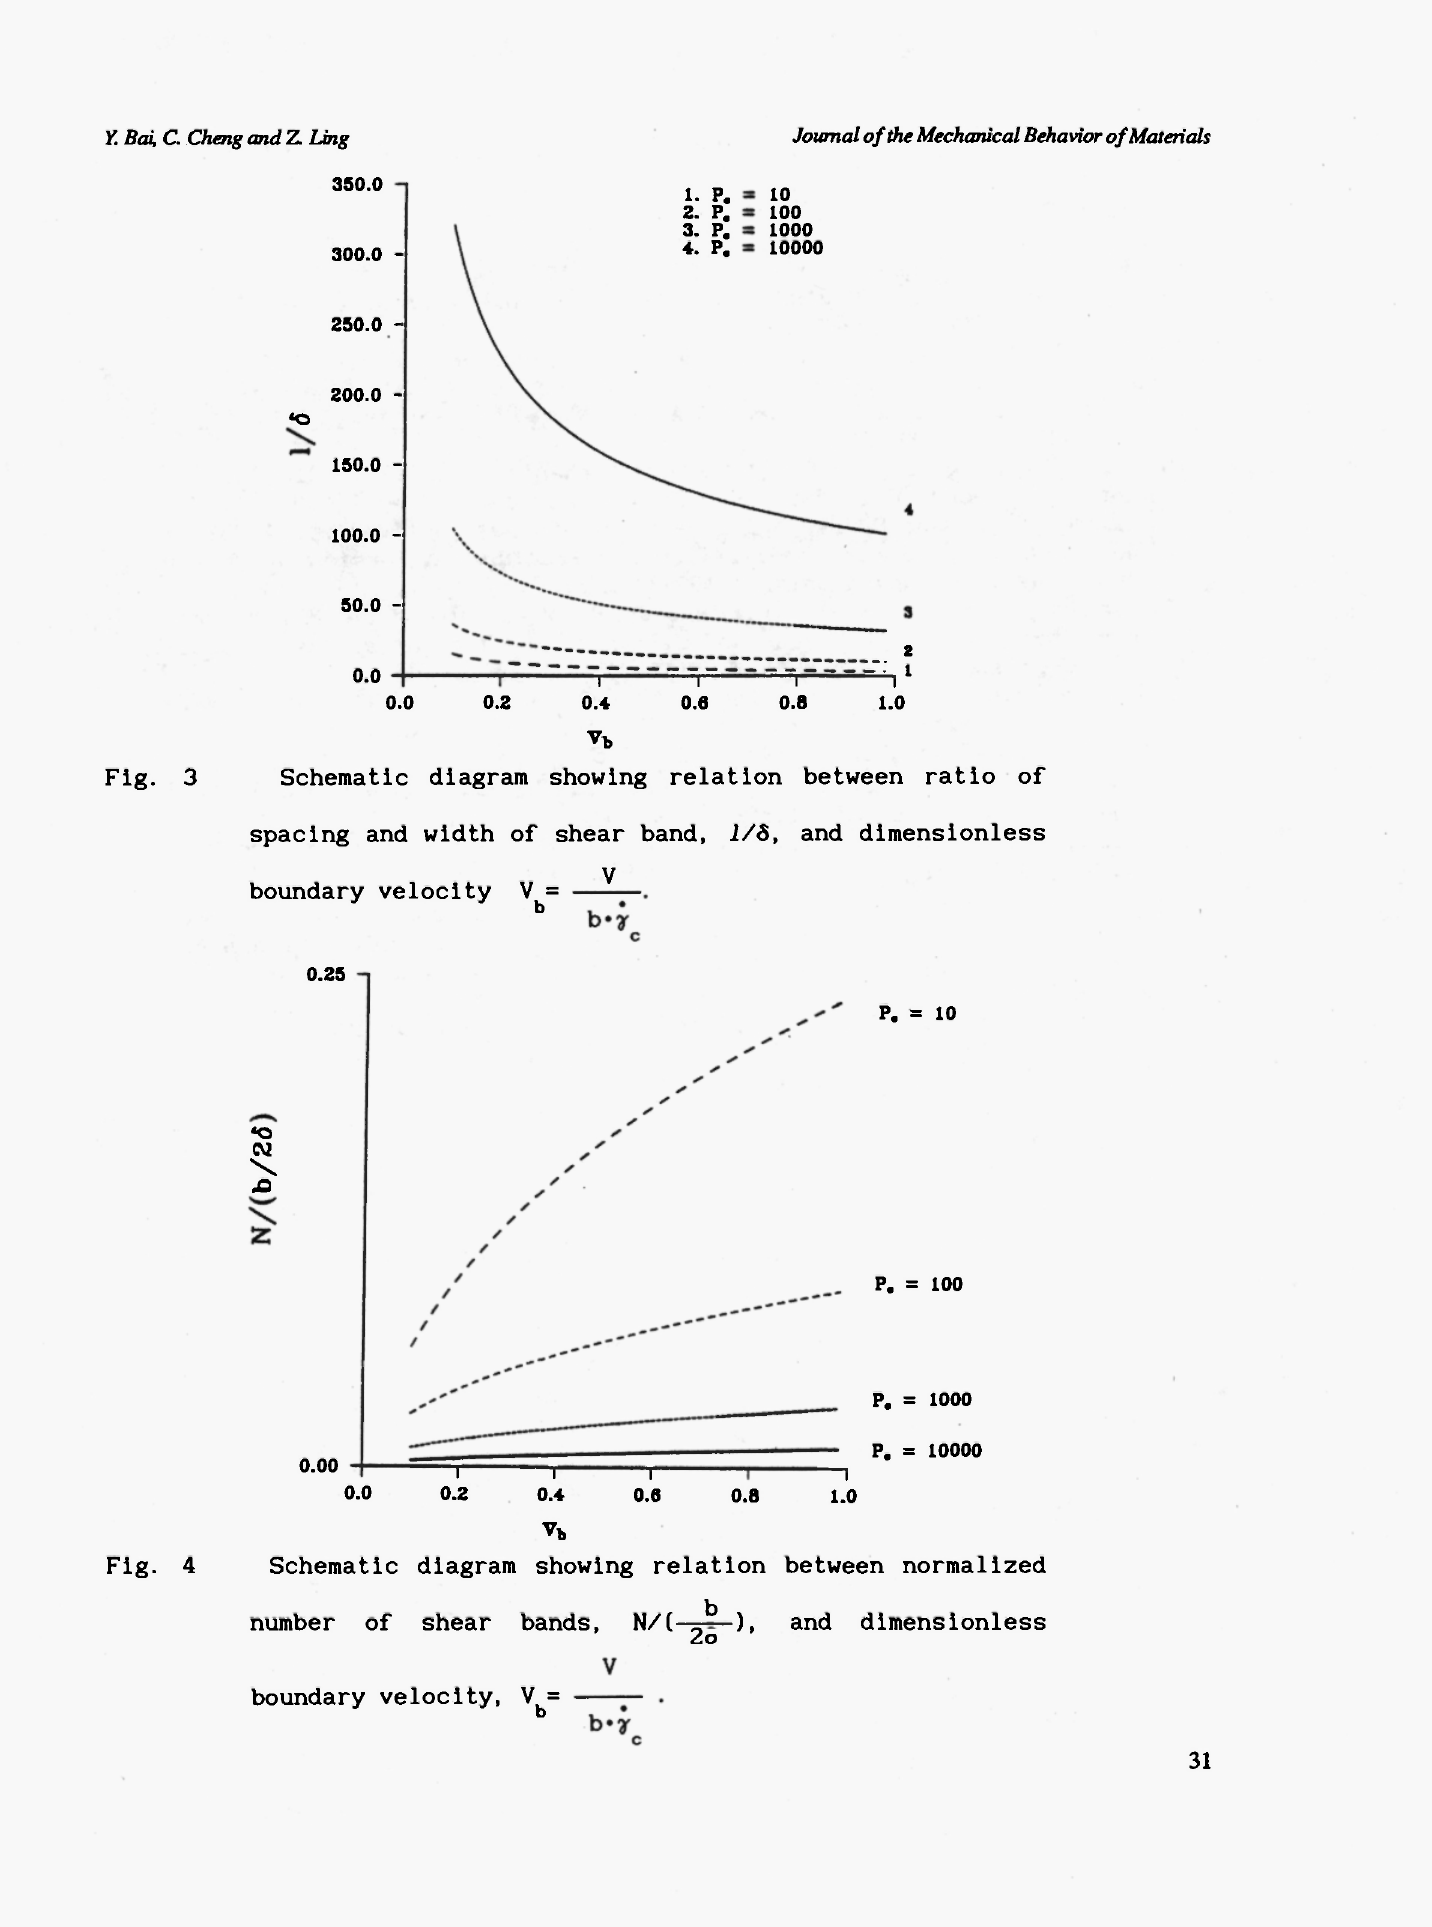
Schematic diagram showing relation between normalized number of shear bands, N/( ^ ), and dimensionless Zo boundary velocity, V = b